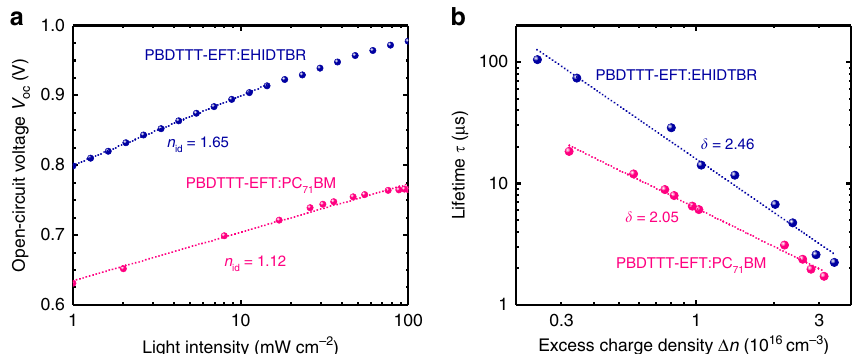
Fig. 3 Analysis of recombination mechanism and dynamics in PBDTTT-EFT-based solar cells. a V oc versus light intensity for PBDTTT-EFT:EH-IDTBR and PBDTTT-EFT:PC 71 BM devices. b Charge-carrier lifetime τ , obtained from TPV, as a function of charge density n , calculated from CE measurements under V δ ) of the studied systems. The dashed lines represent linear fi ts of oc conditions (from 0.2 to 2 suns). The slope presents the recombination order (